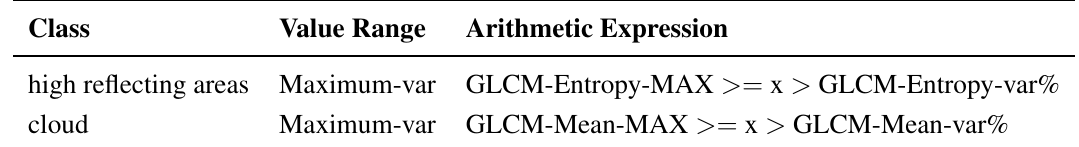
Table 2. Definition of potential mining area and cloud